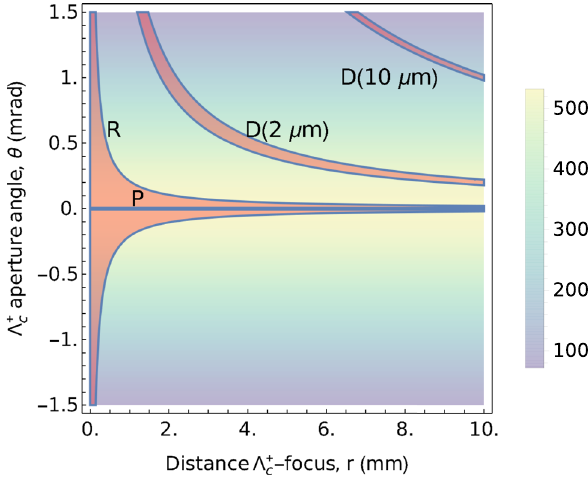
Fig. 6 Regionsofthephasespaceofthevariables ( r ,θ) wherethetrap- ping condition is met for the plain-crystal scheme (P), the double-lens scheme (R), and the double-lens scheme with a vertical displacement between the two focal points of d ( D ( d ) ). The background color gra- dient shows the probability distribution of the (cid:2) + c aperture angle, θ , in Eq. (2). Even though the phase space for the plain-crystal scheme is smaller than the one for vertically displaced focal points, it is centered at the peak of the θ distribution, partially compensating this difference. This plot is antisymmetric for negative values of